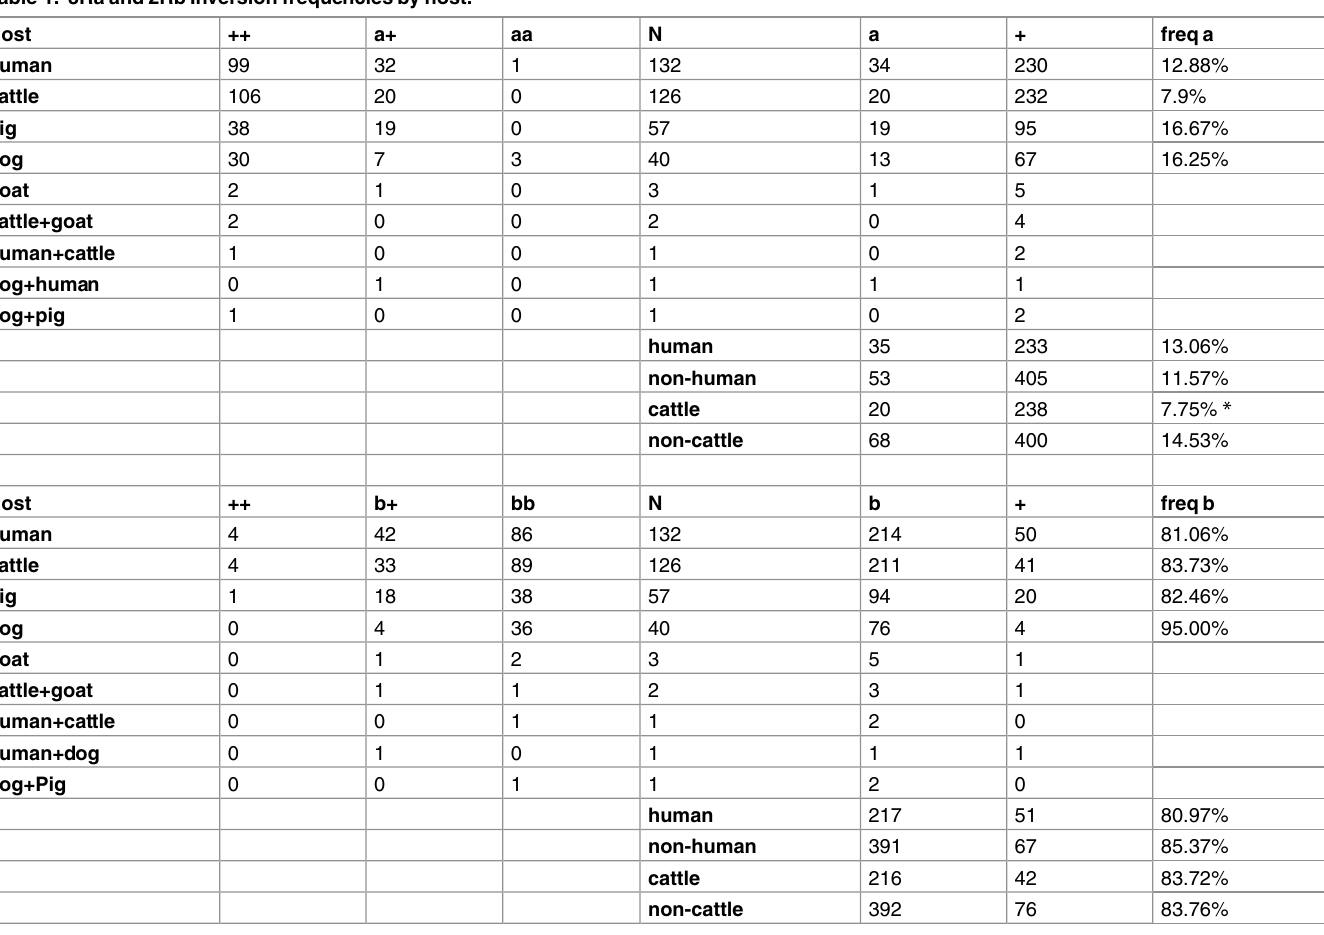
Table 1: Mosquitoeswere collectedfrom the village of Lupiro. The inversion frequencies (freq a or b) were not calculatedfor host categorieswith low sample sizes. Note the significa ntly lower frequencyof 3Ra among cattle-fed mosquitoes ( * ). The sum of human-and cattle-fed mosquitoes(bottomfour categories) included pure (e.g. human)and mixed host (e.g. dog+human)